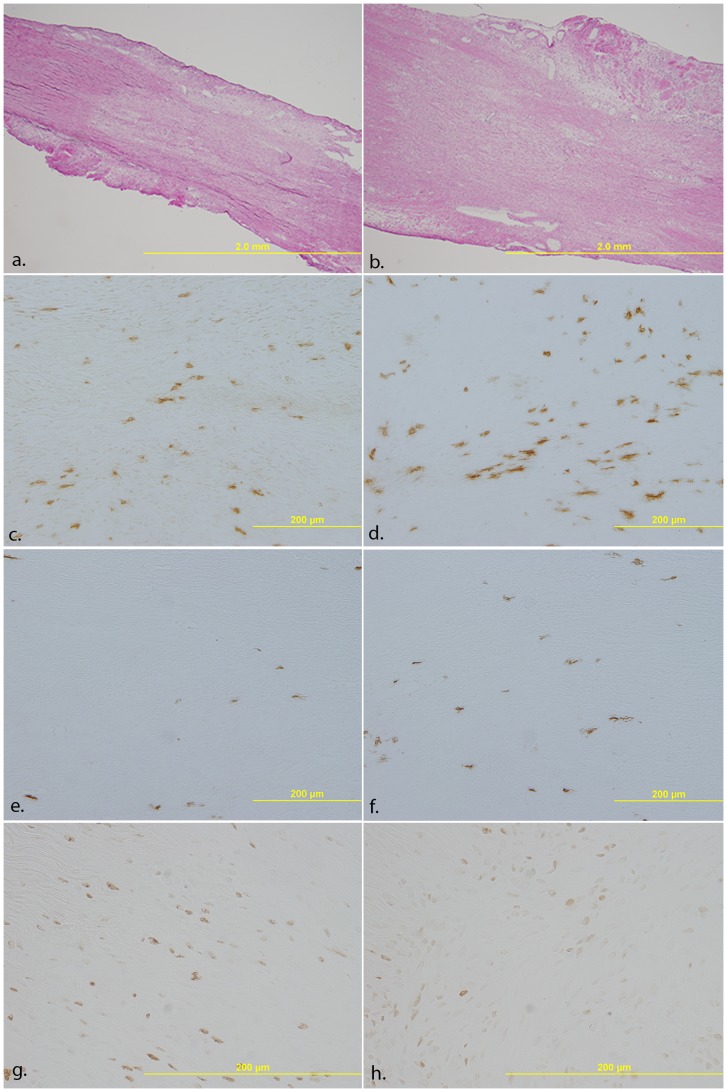
Representative micrographs of the healing MCL after PBS or IL-1Ra treatment.Micrographs demonstrate H&E staining (a–b), and immunohistochemistry of M2 macrophages (c–f), and proliferating cells (g–h) after PBS (left column) or IL-1Ra (right column) treatment. H&E staining of the day 11 MCL indicating larger granulation tissue size (a–b). M2 macrophages 5 days- (c–d) and 11 days post-injury (e–f) increase in number after IL-1Ra treatment. In contrast, proliferating cells decrease on day 5 (g–h) after IL-1Ra administration.